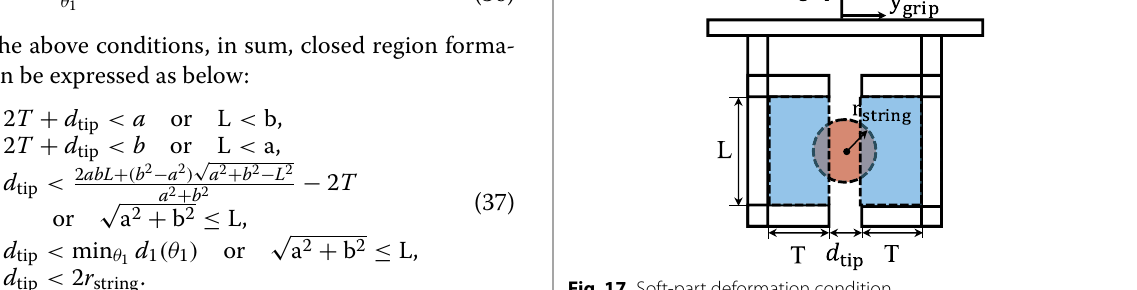
Fig. 17 Soft-part deformation